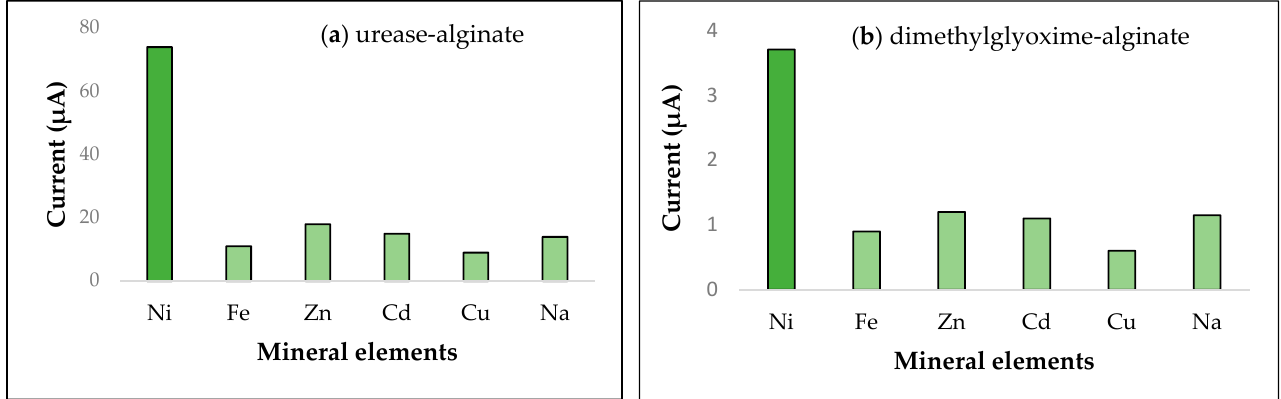
Figure 3. Calibration curve for cyclic voltammograms ( a ) biosensor with urease-alginate and ( b ) dimethylglyoxime-algi- nate.